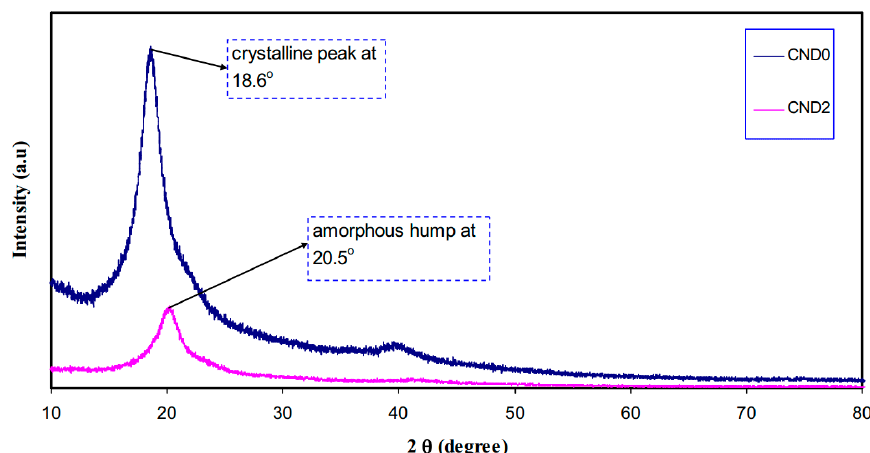
Figure 20. CN-dots XRD spectrum at room temperature [191].